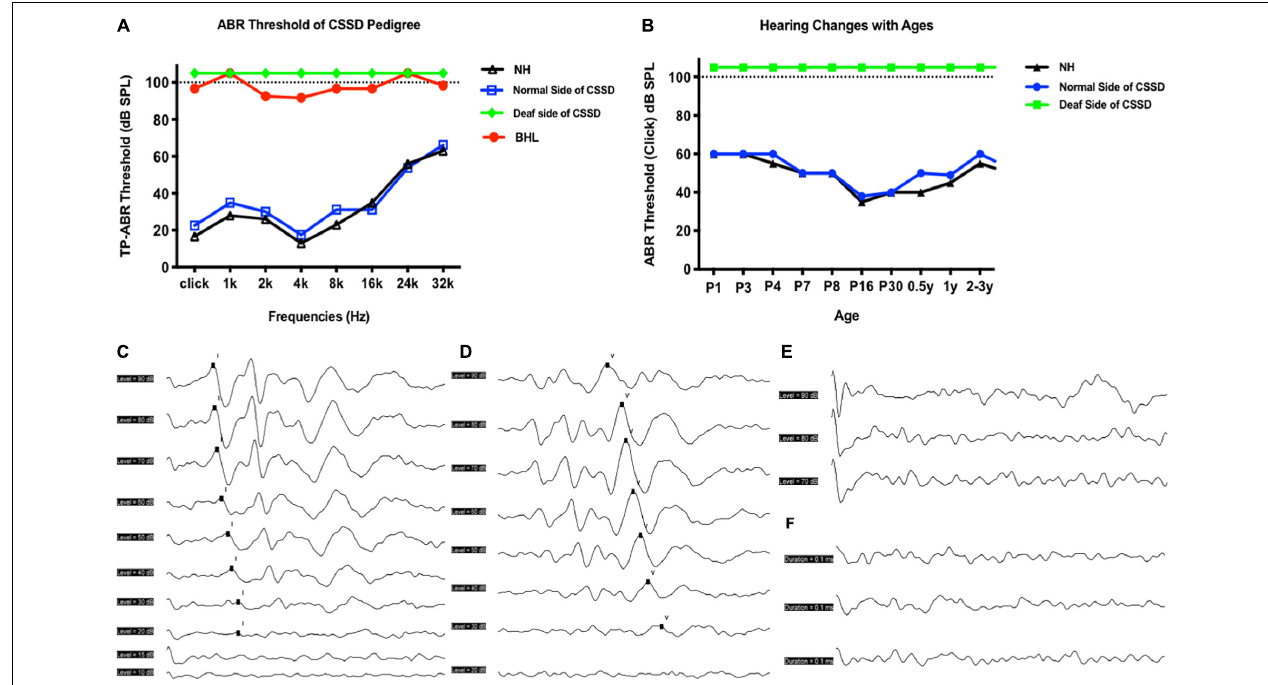
FIGURE 2 | Auditory brainstem response (ABR) hearing thresholds of congenital single-sided deafness (CSSD) pedigree. (A) ABR thresholds from 1 to 32 kHz of different hearing phenotypes in CSSD pedigree. (B) ABR thresholds changes in the CSSD individuals with age compared to NHs. In Panels (A,B) , the threshold of